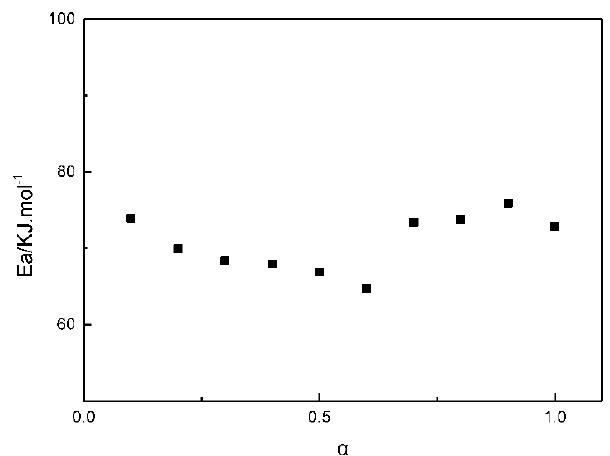
Figure 4. The change of the apparent activation energies during the curing reaction of GAPSPs with the conversion rate.